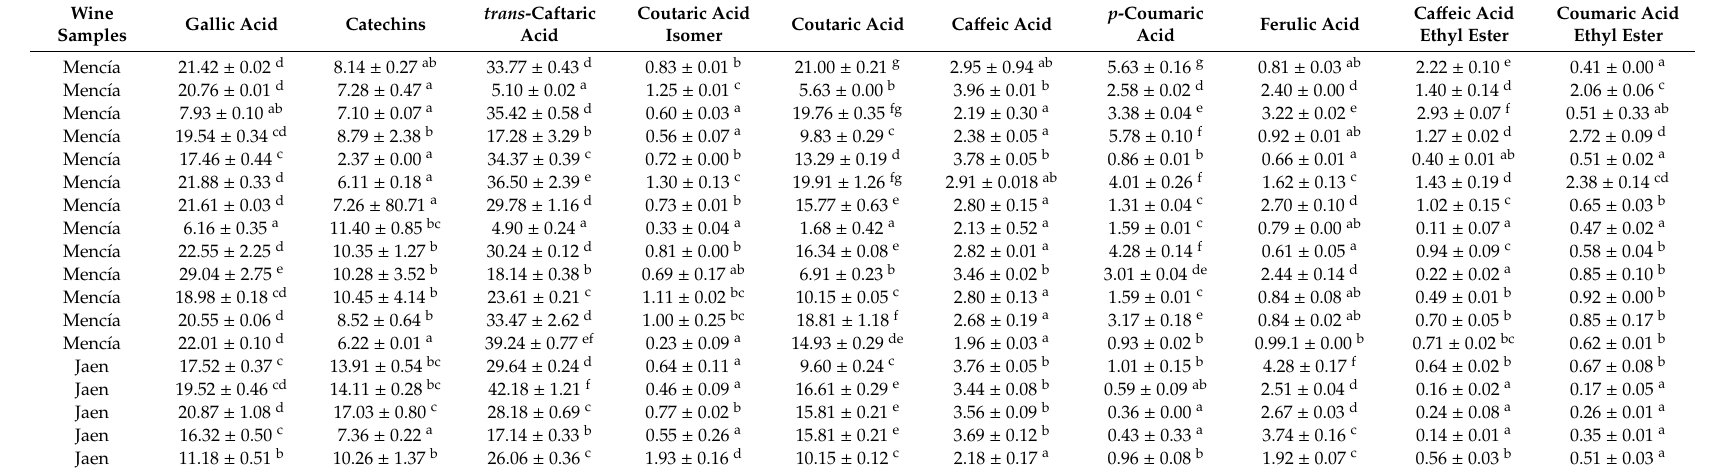
Table 1. ‘Menc í a’ and ‘Jaen’ red wines phenolic profile (phenolic acid and catechin) expressed in mg /